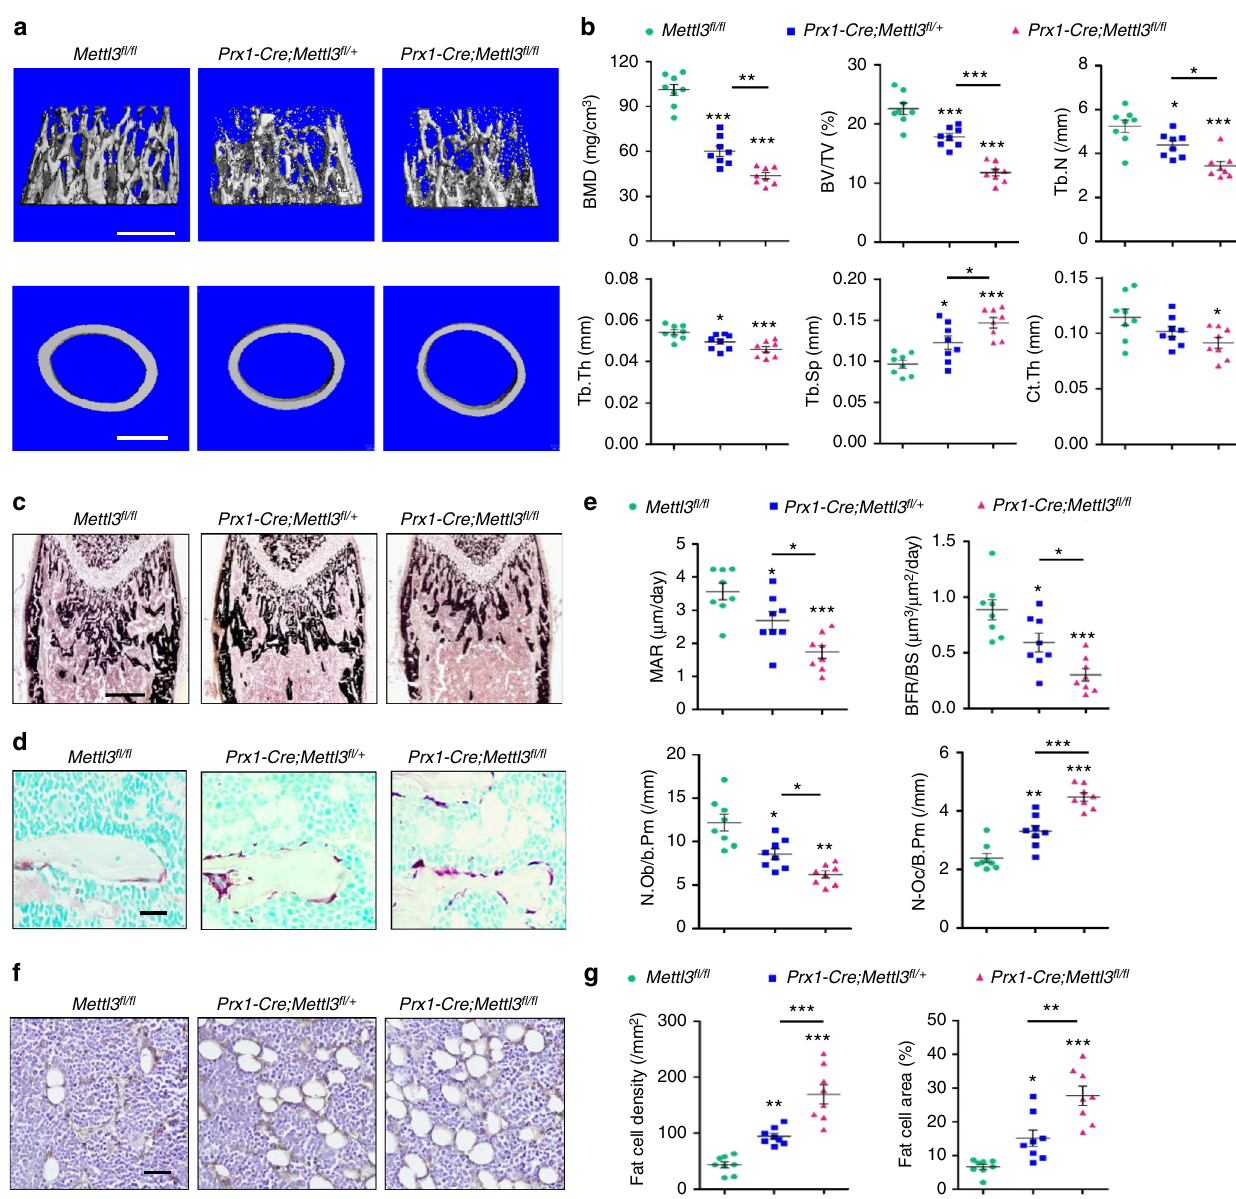
Fig. 1 Deletion of Mettl3 in MSCs leads to low bone mass and high marrow adiposity. a Representative μ CT images of distal femurs and midshaft cortical bone. Scale bar, 500 μ m. b Quantitative μ CT analyses of distal end of femurs ( n = 8). c Von Kossa staining of undecalci fi ed sections of femurs. Scale bar, 500 μ m. d TRAP staining of femur sections. Scale bar, 50 μ m. e Histomorphometric analyses of trabecular bone from the femur metaphysic ( n = 8). f Immunohistochemical staining of FABP4. Scale bar, 50 μ m. g Number and area of adipocytes in the distal marrow per tissue area ( n = 8). Data are expressed as mean ± s.e.m.; * P < 0.05, ** P < 0.01, *** P < 0.001 by one-way ANOVA with Tukey ’ s post hoc test